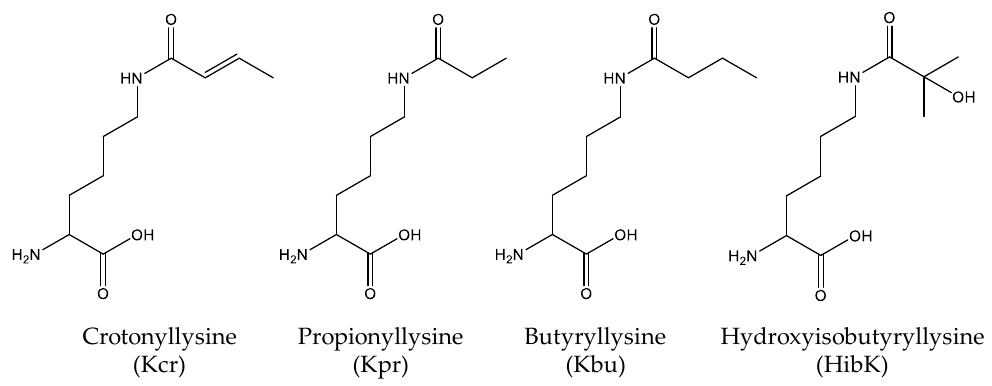
Figure 5. The structures of other modifications of lysine, including crotonylation, propionylation, butyrylation and 2-hydroxyisobutyrylation.